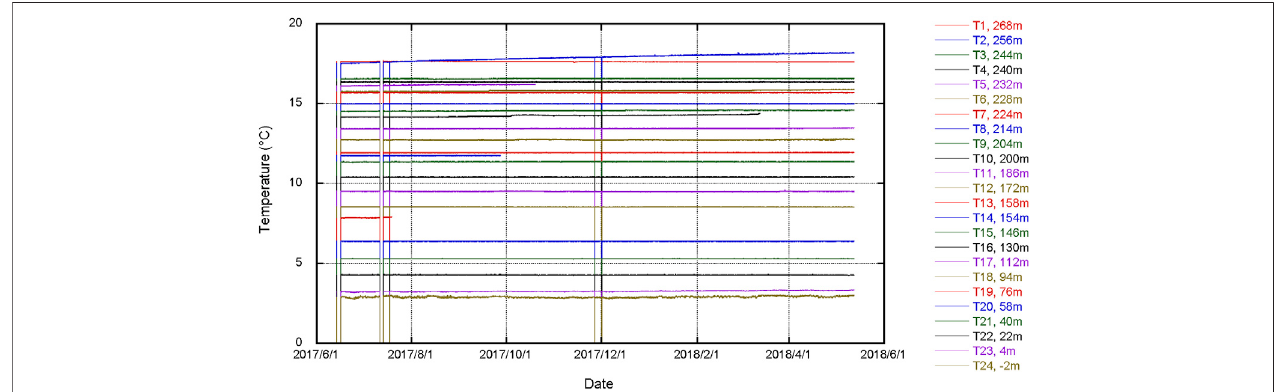
FIGURE 4 | Eleven-month time-series of temperatures recorded from June 2017 through May 2018 with the thermistor cable originally deployed in July 2016. As detailed in the text, compromised later sections of readings from fi ve sensors have been masked from this plot.